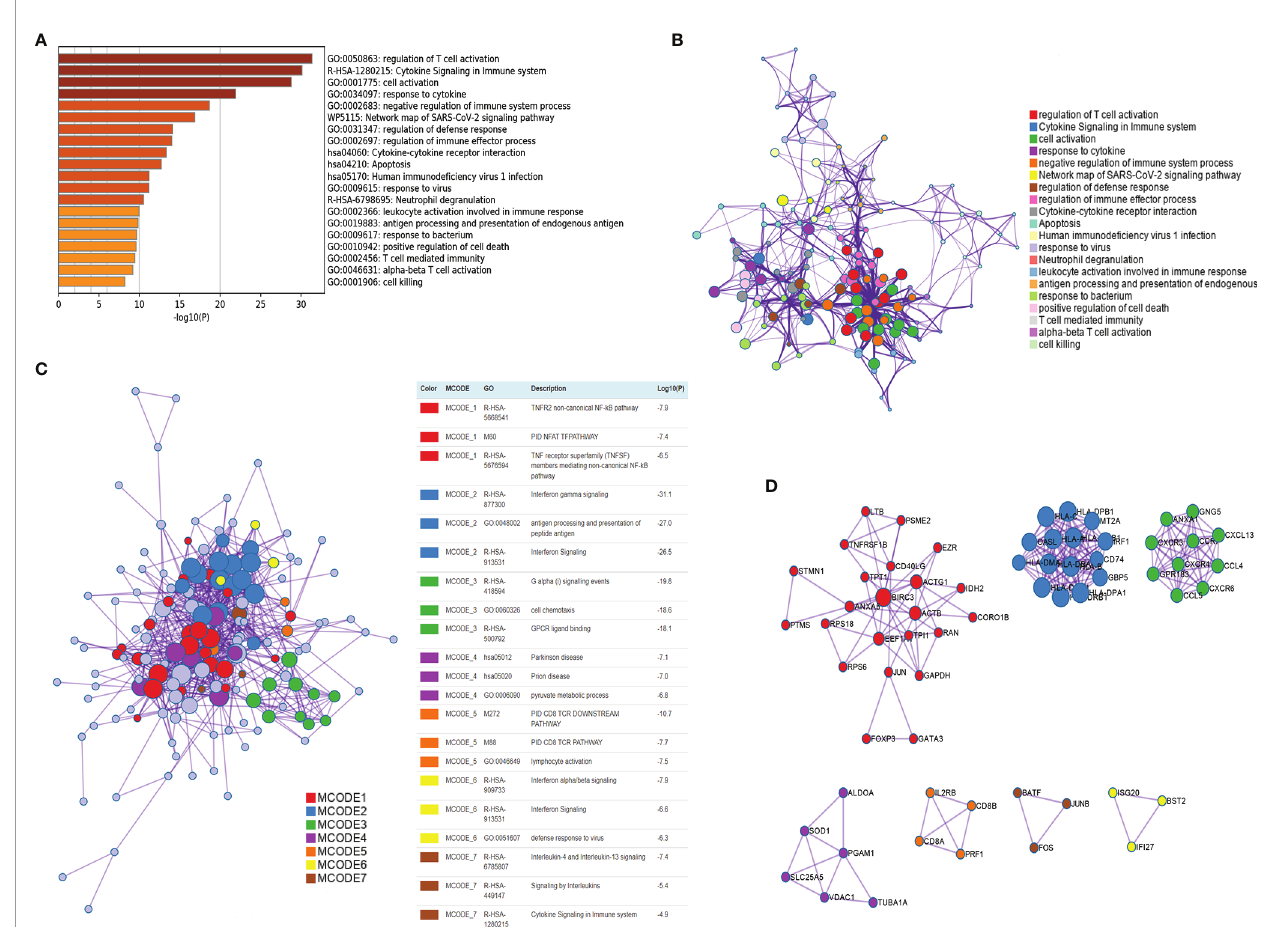
FIGURE 4 | Functional enrichment of CD4 + Tconv-related genes and visualization of interactome analysis results. (A) Metascape enrichment analysis for the CD4 + Tconv-related genes. (B) Metascape enrichment network visualization showing the intra-cluster and inter-cluster similarities of enriched terms. (C) Metascape visualization of the interactome network formed by CD4 + Tconv-related genes candidates, where the MCODE complexes are colored according to their identities. (D) Seven MCODE complexes automatically identi fi ed in Metascape, colored by their identities. Their functional labels are generated based on the top-three functional enriched